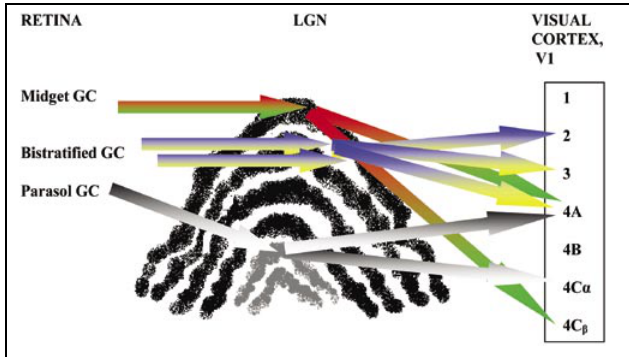
Figure 2: A very simplified representation of retinal ganglion cell (GC) neural input to the lateral genicu- late nucleus (LGN) and primary visual cortex, area V1 is indicated. The four parvocellular (PC) layers are in- dicated in black, the two magnocellular (MC) layers are in grey and the koniocellular (KC) or interlaminar layers are in white. Layer 1 of area V1 is most super- ficial, that is, nearest the skull or cranium. Coloured arrows are used to roughly indicate the three opponent pathways but for simplicity arrows are only linked to a single PC, MC or KC layer. In reality, all layers would be involved and so, for example, signals from midget ganglion cells would pass to all four PC layers (the black layers in the figure). And, similarly, for the bistratified GC to all KC layers (in white) and for the parasol GC to both MC layers (in grey) for non-chro- matic (luminance) signals